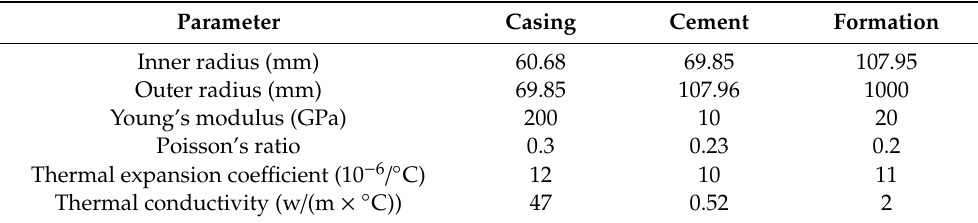
Table 1. The geometrical parameters and mechanical and thermal properties of wellbore components for a reference